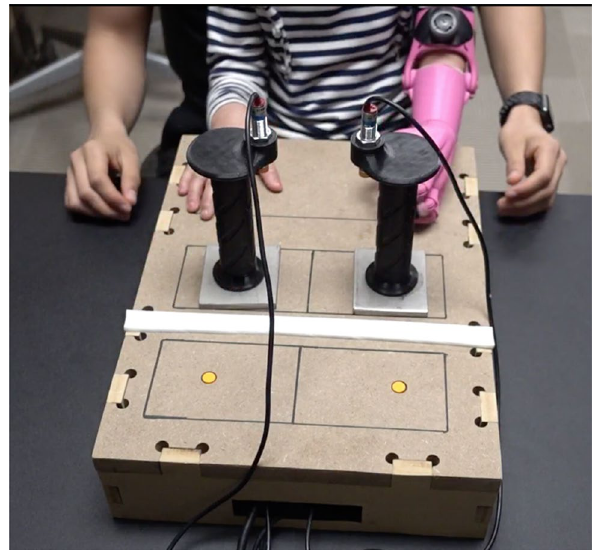
Figure 2. Bimanual reaching task with two small trays. The task involved the participant grasping the handles, transporting the small trays to the top ledge, releasing the tray handles and returning their hands to the standardize start